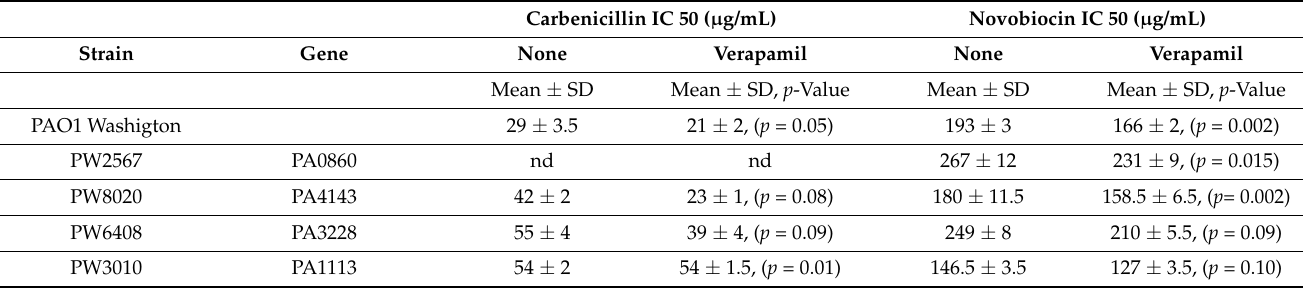
Table 3. Effects of verapamil on the sensitivity of P. aeruginosa PAO1 and its mutants to carbenicillin and